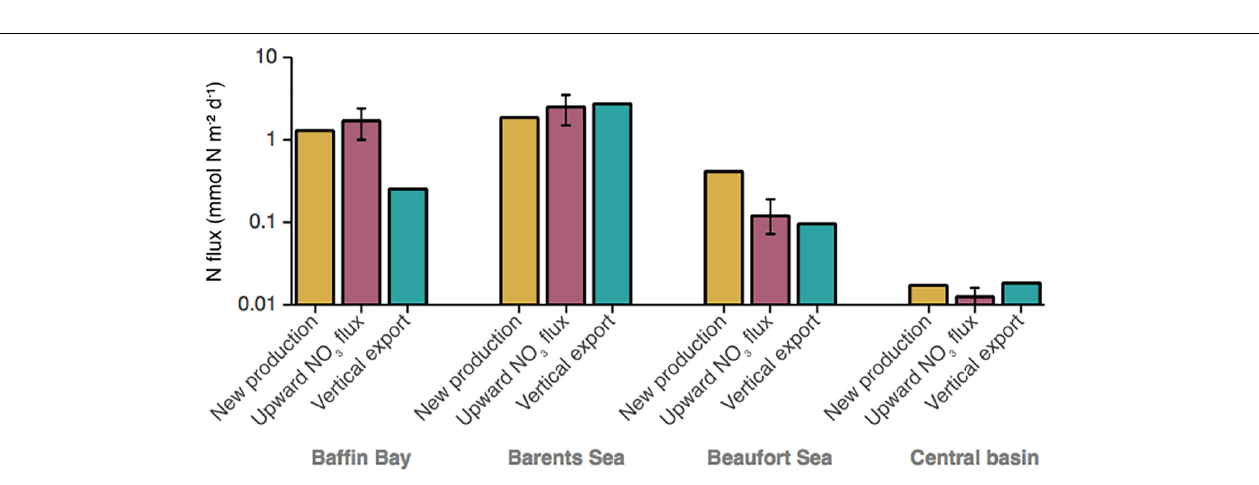
FIGURE 5 | Annual nitrogen fluxes in the Arctic surface ocean. Winter average upward nitrate flux, new production, and vertical downward particle export (converted to nitrogen units using the Redfield ratio) at 200 m depth compared across four regions of the Arctic Ocean. Data sources: Nitrate fluxes, see Table 1 ; new production, Sakshaug (2004); export production, Cai et al. (2010), Honjo et al. (2010), and Wiedmann (2015). Error bars were systematically only available for nitrate fluxes.